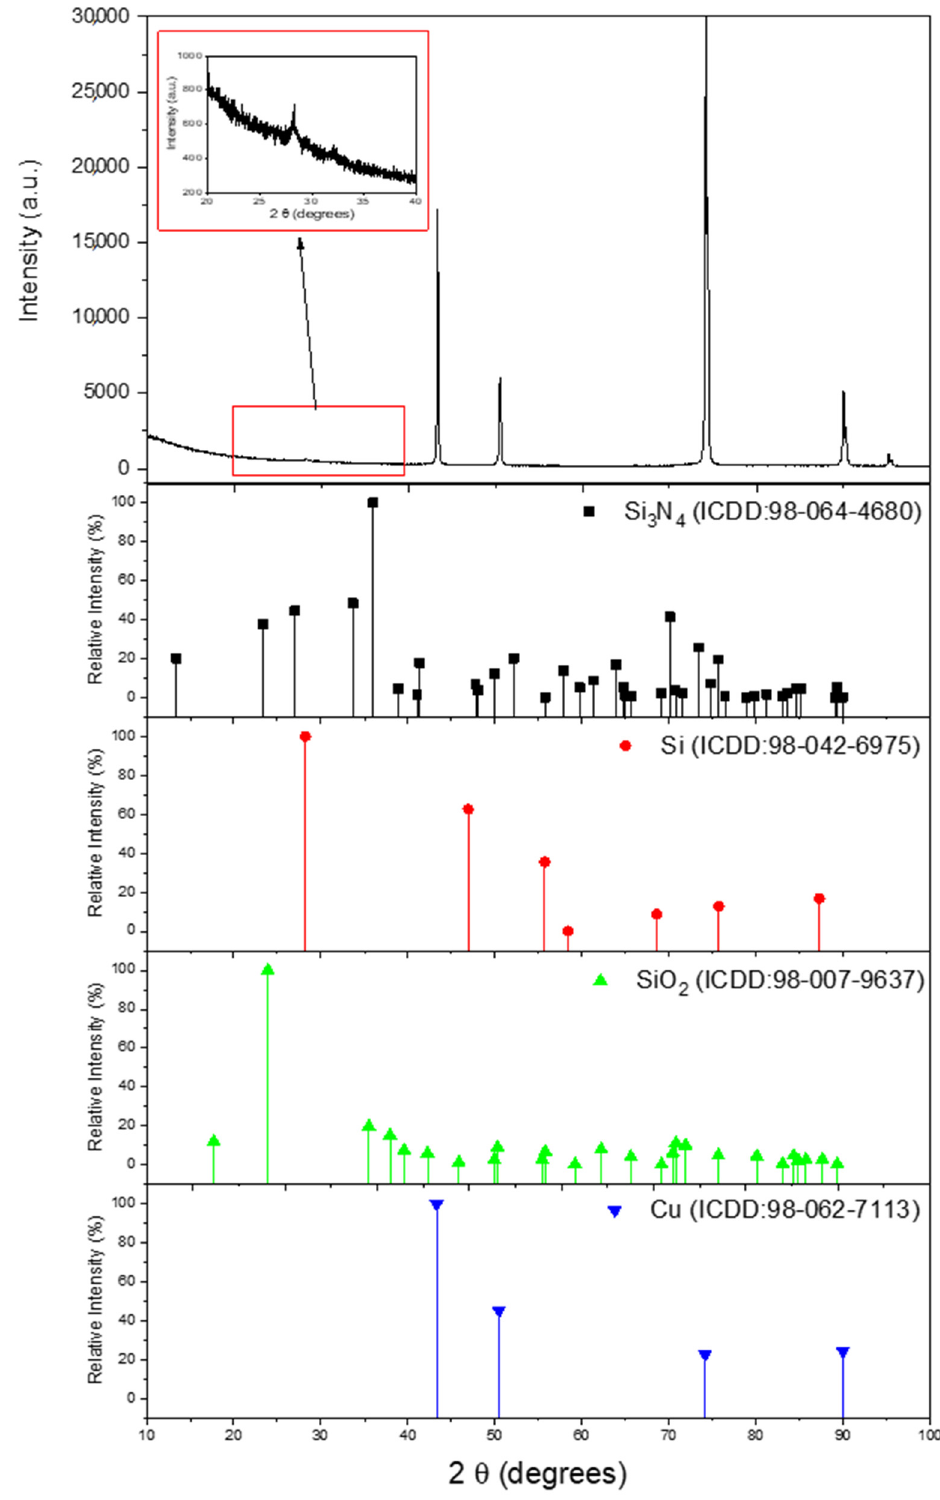
Figure 1. Composite XRD spectra of Si 3 N 4 @Si@Cu film in comparison with Si 3 N 4 , Si, SiO 2 , and Cu. The inset graph shows the relative intensity of Si 3 N 4 in the sample.